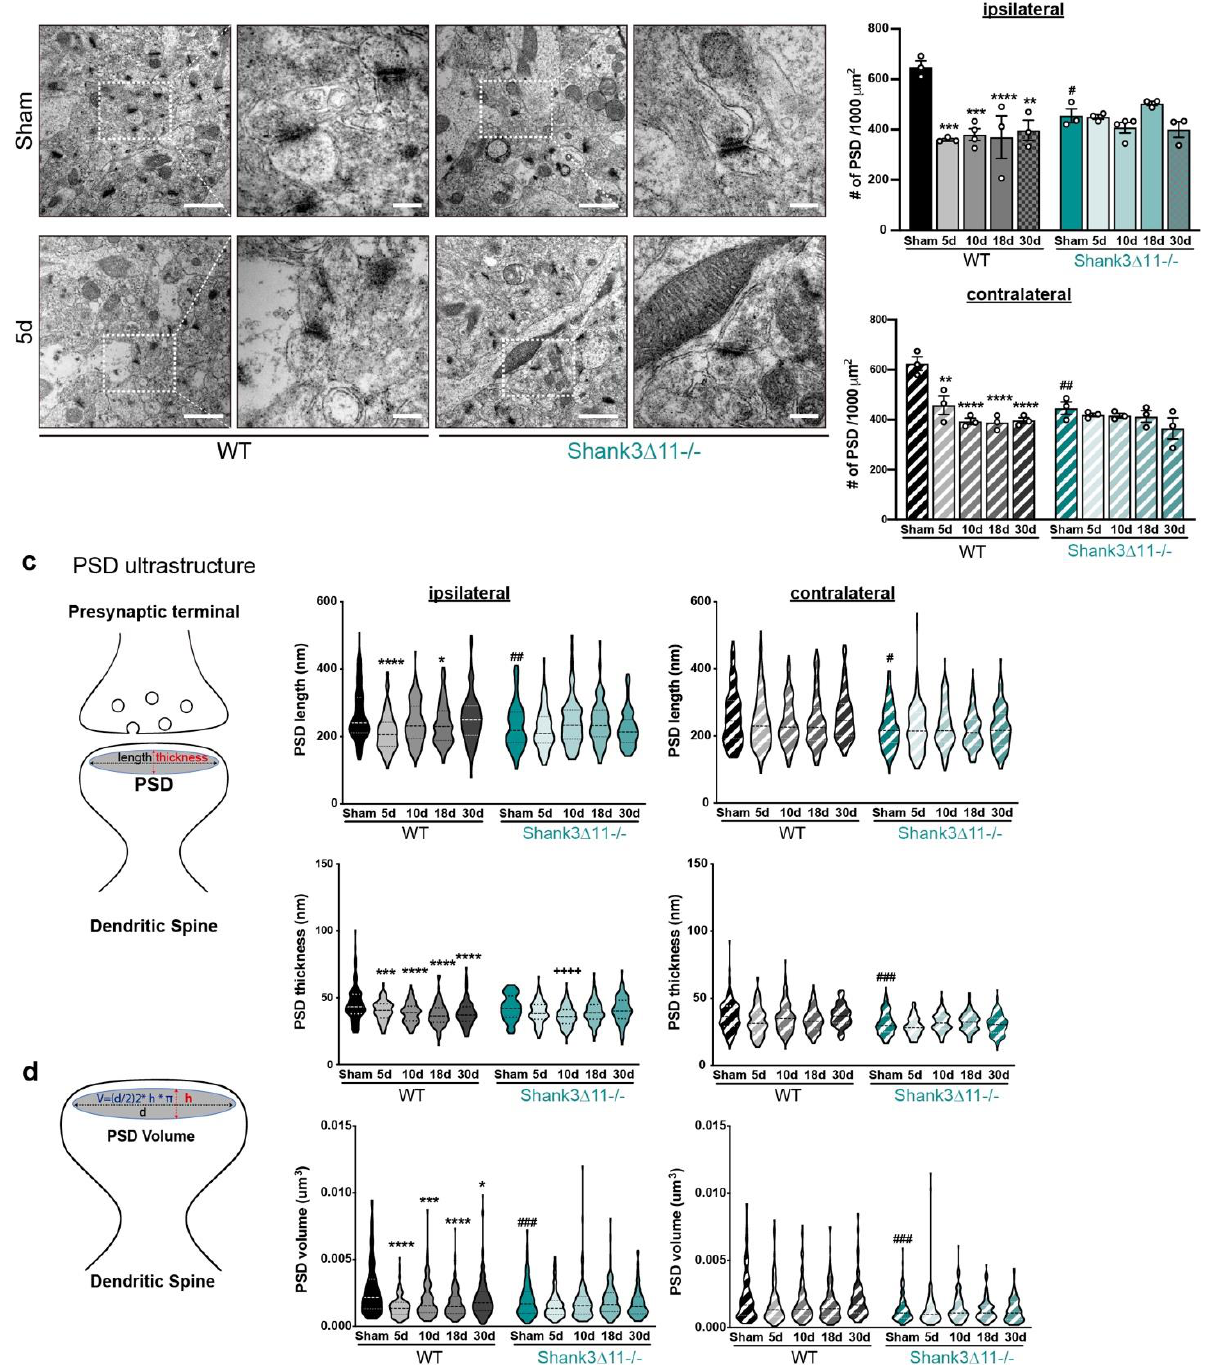
Figure 2. The overall number and ultrastructure of the postsynaptic density (PSD) of excitatory synapses are mainly affected in wild-type animals after mTBI. ( a ) Representative electron micrographs of synapses in the CA1 hippocampus ipsilateral side of WT mice (left panel) and Shank3 ∆ 11 − / − (right panel) after 5 d of mTBI. White dashed squares represent the PSD structures quantified (with a 25,000 × magnification: scale bar = 1000 nm), whose size were subsequently analyzed (80,000 × magnification: scale bar = 200 nm). ( b ) Determination of the number of PSDs structures after mTBI on the ipsilateral side (upper panel, filled bars) and the contralateral side (bottom panel, hatched bars) for WT (black bars) and in Shank3 ∆ 11 − / − mice (turquoise bars). N = 3, error bars represent mean ± SEM; two-way ANOVA (genotype × mTBI intervention) with Bonferroni’s post hoc comparison test